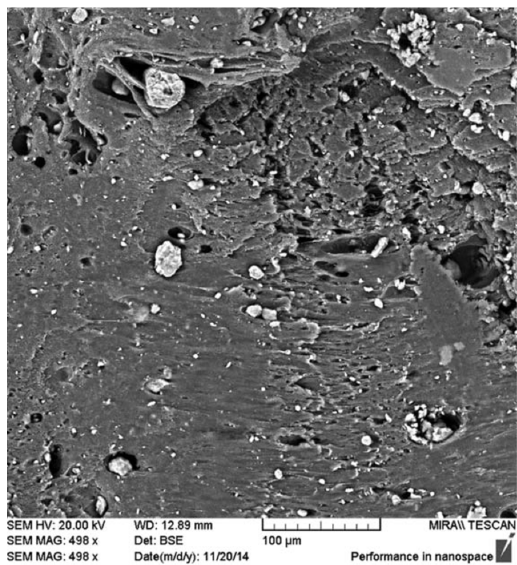
Figure 4. Backscattered electron (BSE)-SEM micrograph of the PLA/HNT composite. Reproduced with permission from Ref. [126]. Copyright 2015 John Wiley and Sons.